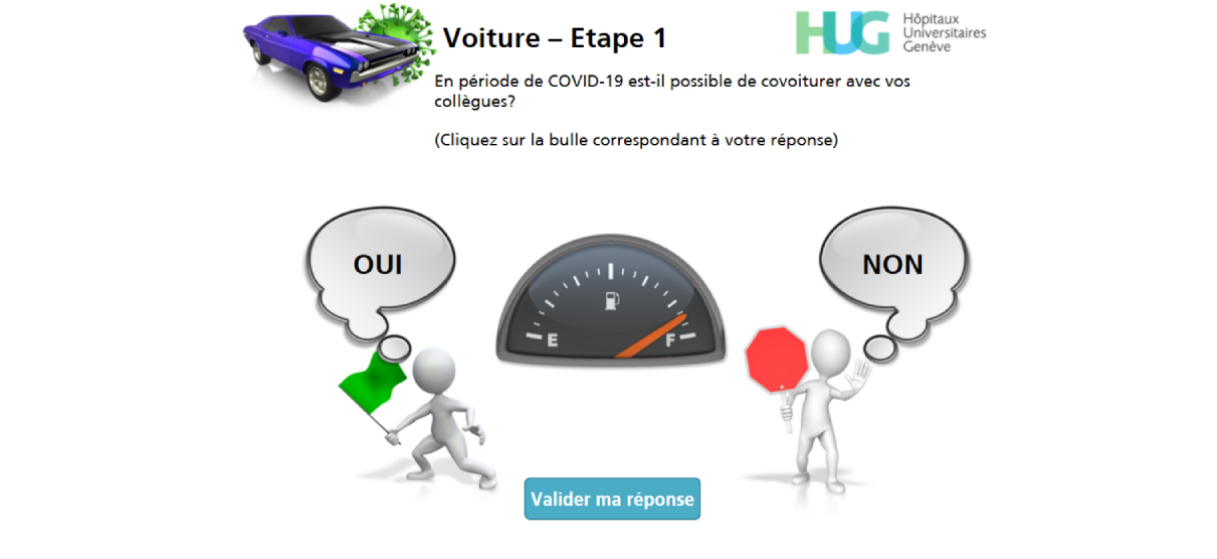
Figure 3. First version of a simple-choice